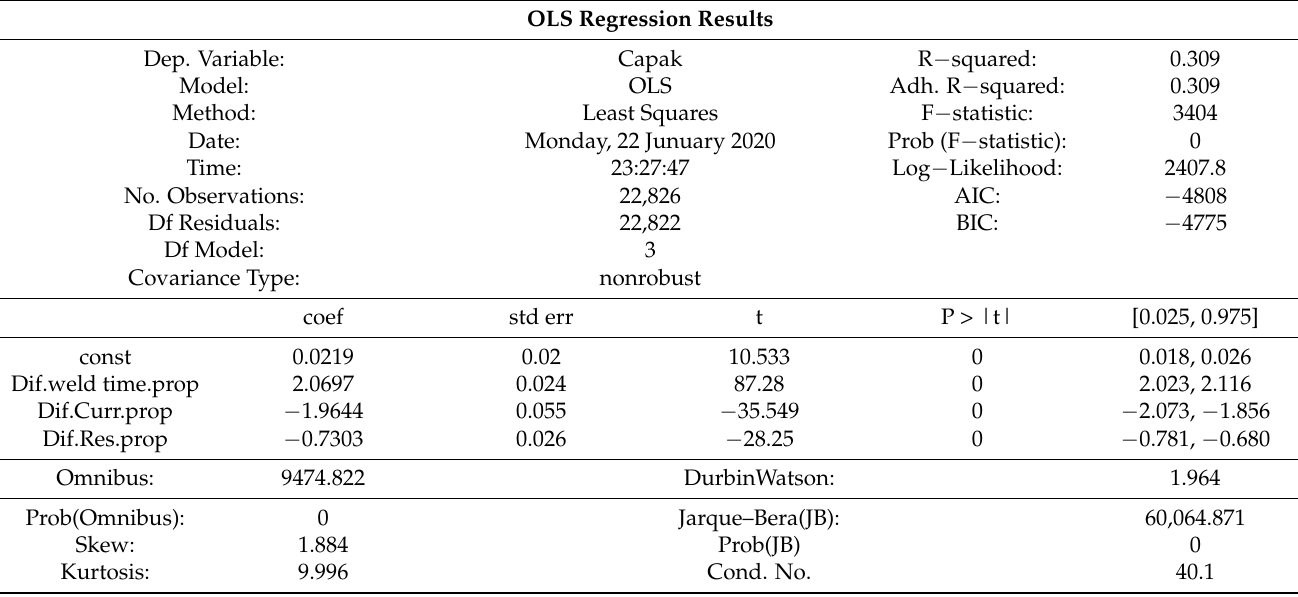
Table 9. OLS regression results. OLS Regression